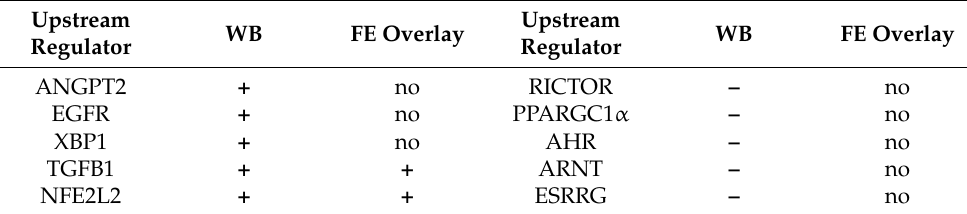
Table 4. Upstream regulators that were predicted to be activated ( + ) or inhibited ( – ) in wooden breast myopathy (WB) proteomics (from Kuttappan et al. [2]) with the resulting prediction when the FE on the WB upstream regulator network. The designation ‘no’ indicates that no prediction was made with the FE overlay (projection of FE dataset onto WB myopathy